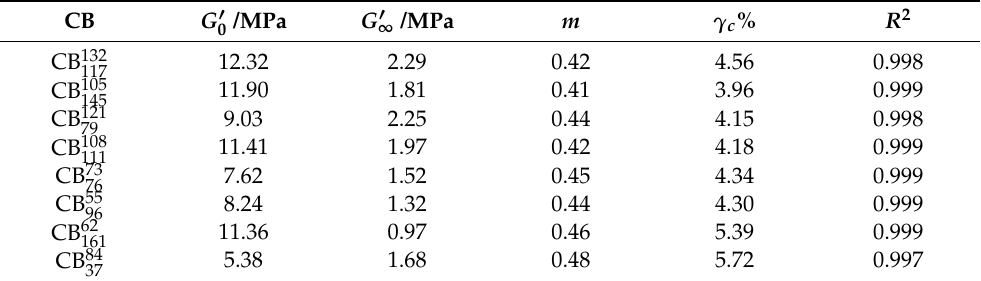
Figure 2. The strain dependence of G (cid:48) for various grades of CB. Symbols represent the experimental data points; lines represent optimized curve fittings. Table 3. Non-negative fitting of G (cid:48) ( γ ) according to Equation